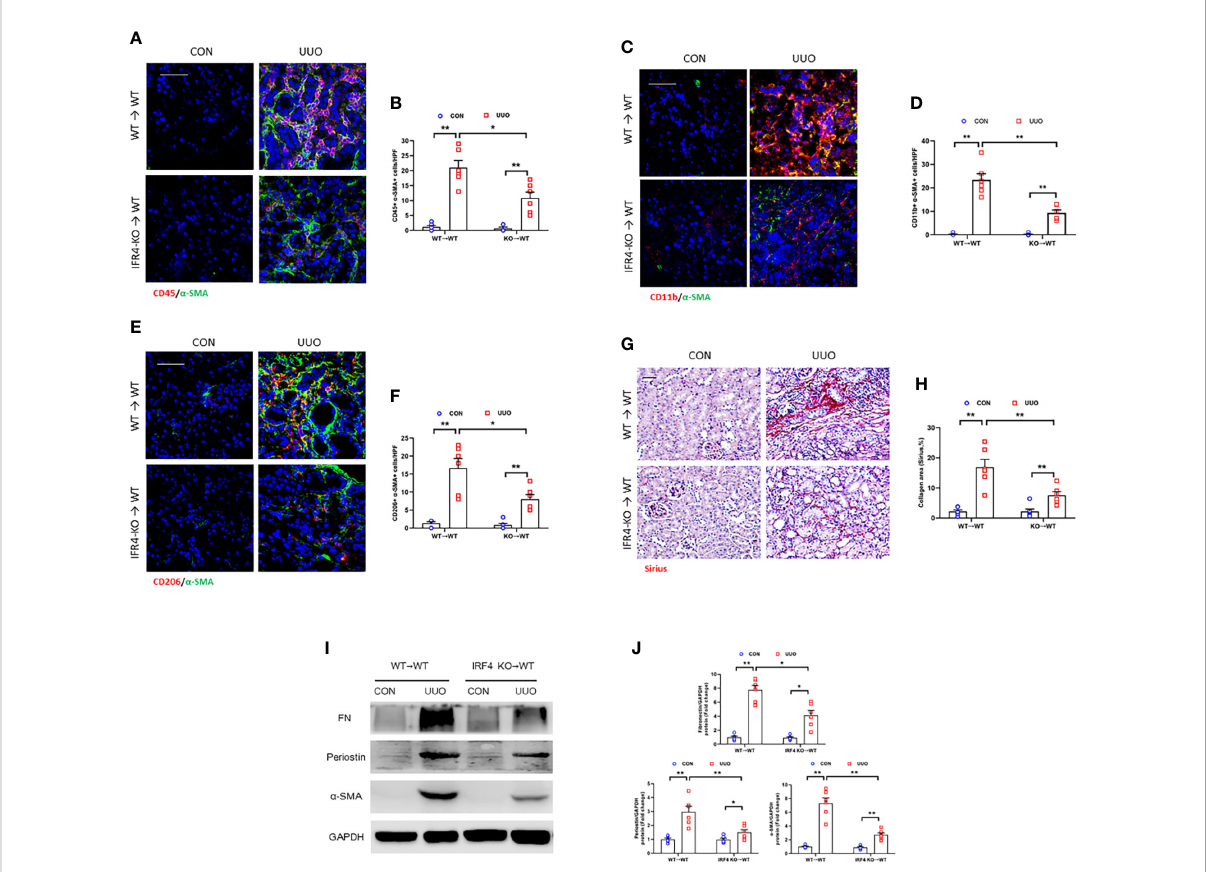
FIGURE 9 IRF4 deletion in myeloid cells inhibits myeloid fi broblast activation, M2MMT, and kidney fi brosis. (A) Kidney sections from WT ! WT and IRF4- KO ! WT mice after UUO treatment were stained for CD45 (red), and a -SMA (green). (B) Quantitative analysis of CD45 + - a -SMA + cells. (C) Kidney sections from WT ! WT and IRF4-KO ! WT mice after UUO treatment were stained for CD11b (red), and a -SMA (green). (D) Quantitative analysis of CD11b + - a -SMA + cells. (E) Kidney sections from WT ! WT and IRF4-KO ! WT mice after UUO treatment were stained for CD206 (red) and a -SMA (green). (F) Quantitative analysis of CD206 + - a -SMA + cells. (G) Kidney sections from WT ! WT and IRF4-KO ! WT mice after UUO treatment were stained with Sirius red. (H) Quantitative analysis of collagen area. (I) Western blots bands of protein expressions in the kidneys. (J) Quantitative analysis of protein levels. * P <0.05 or ** P <0.01; n = 6; Bar = 50 m m. WT, wild-type; KO, knockout; HPF, high-power fi